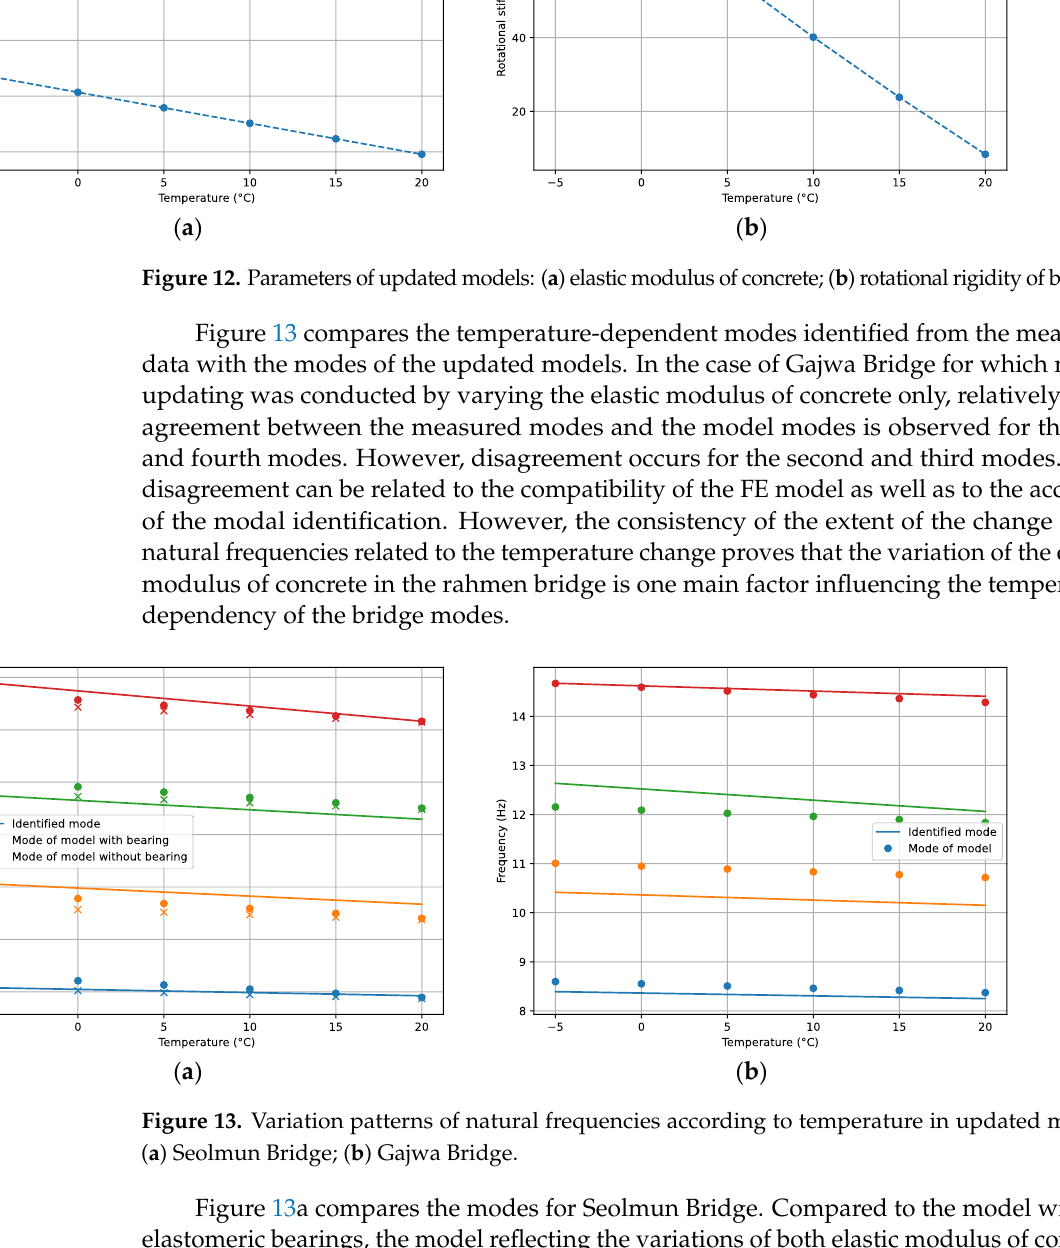
Figure 13. Variation patterns of natural frequencies according to temperature in updated models: ( a ) Seolmun Bridge; ( b ) Gajwa Bridge.